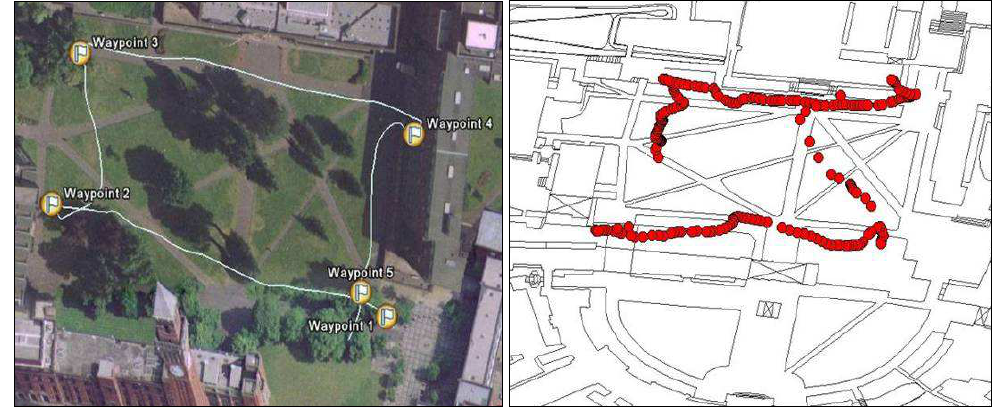
Fig. 1. Sample output of GPS track-logs for the University of Birmingham campus, from Google Earth (left), and ArcMap